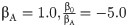
Probability of choosing the right-hand aperture as a function of its width.The figure shows example logistic functions for zero bias, aperture sensitivity = 1.0 (βA=1.0,β0βA=−5.0; solid red curve); zero bias, aperture sensitivity = 2.0 (βA=2.0,β0βA=−5.0; dashed red curve); right bias, aperture sensitivity = 1.0 (βA=1.0,β0βA=−4.0; solid green curve); left bias, aperture sensitivity = 1.0 (βA=1.0,β0βA=−6.0; solid black curve). The ordinate on the right in this figure and in Figs 3 and 4 shows the Laterality Index LI, as defined in ‘Materials and methods’.